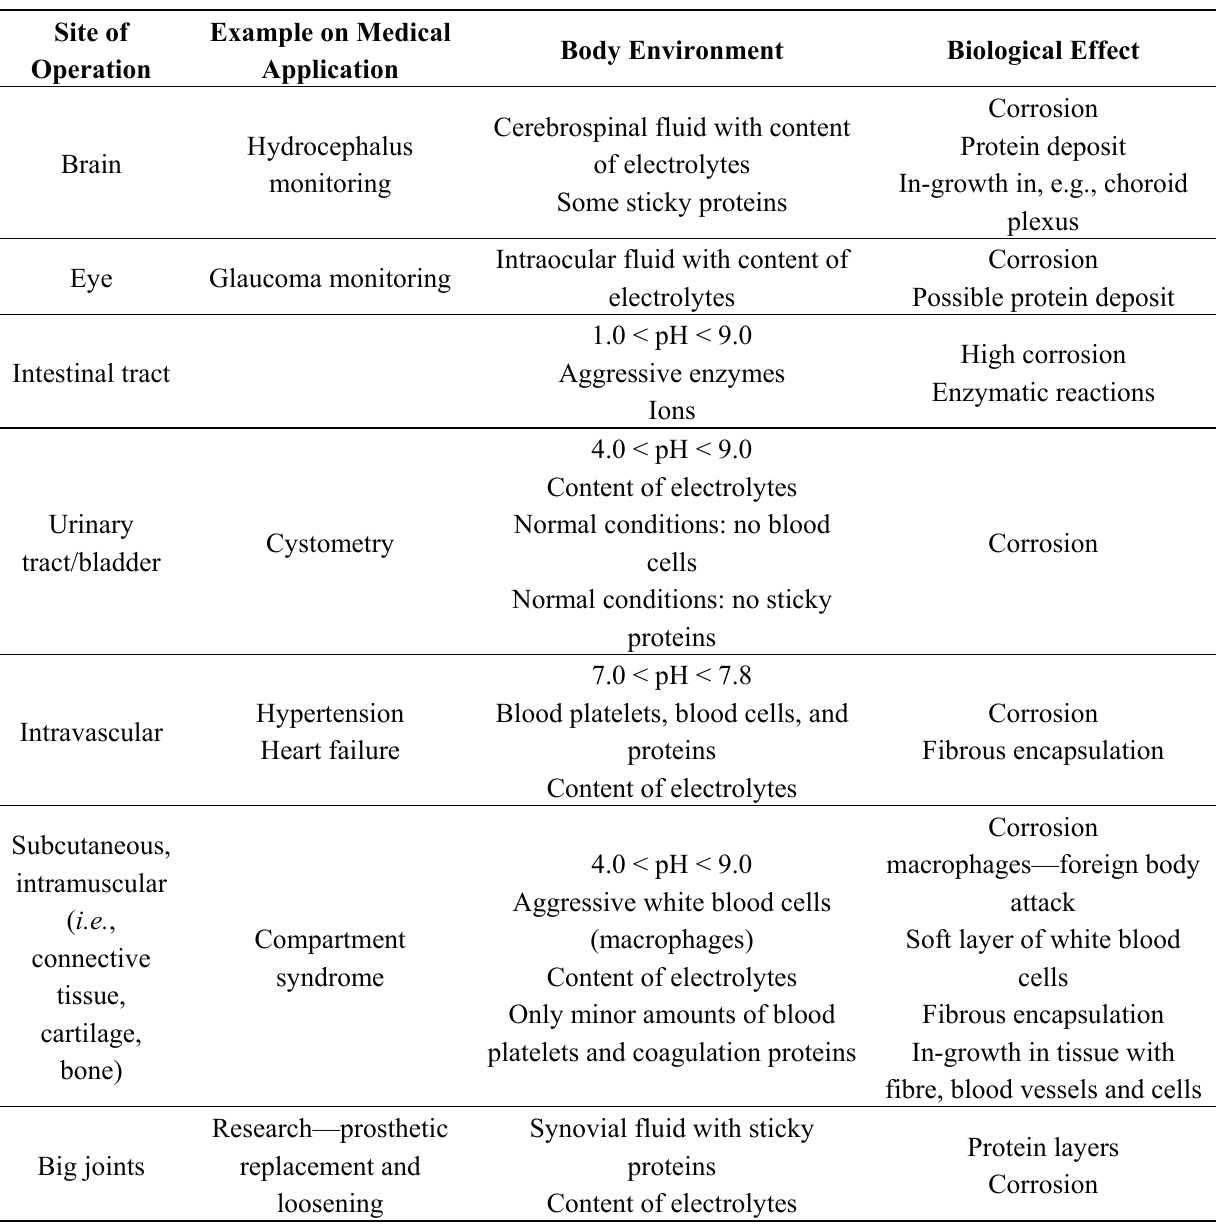
Table 1. Site of operation and body